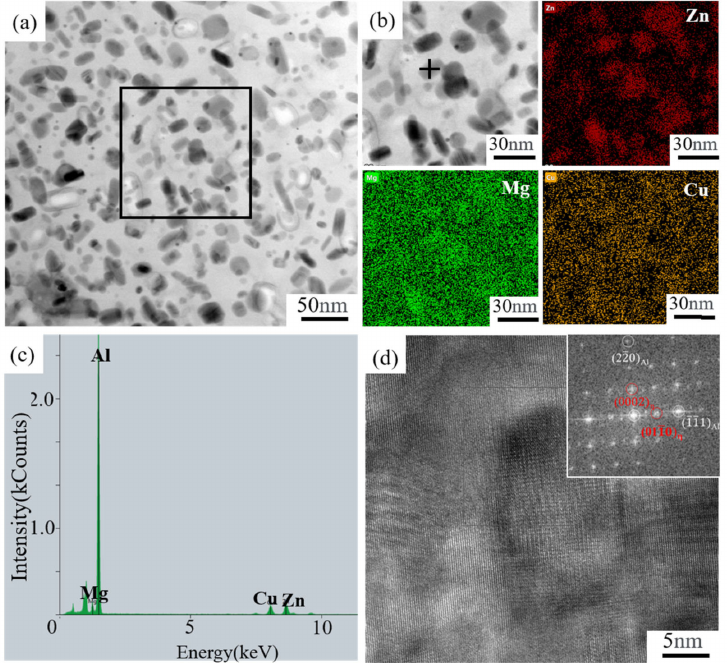
Figure 3. ( a ) Bright-field TEM of the overaged Al-Zn-Mg-Cu alloy; ( b ) the precipitates in higher magnification and elemental map analysis of Zn, Mg, and Cu; ( c ) point EDS of the precipitate marked in Figure 3b; ( d ) HRTEM of the precipitate and fast Fourier transform